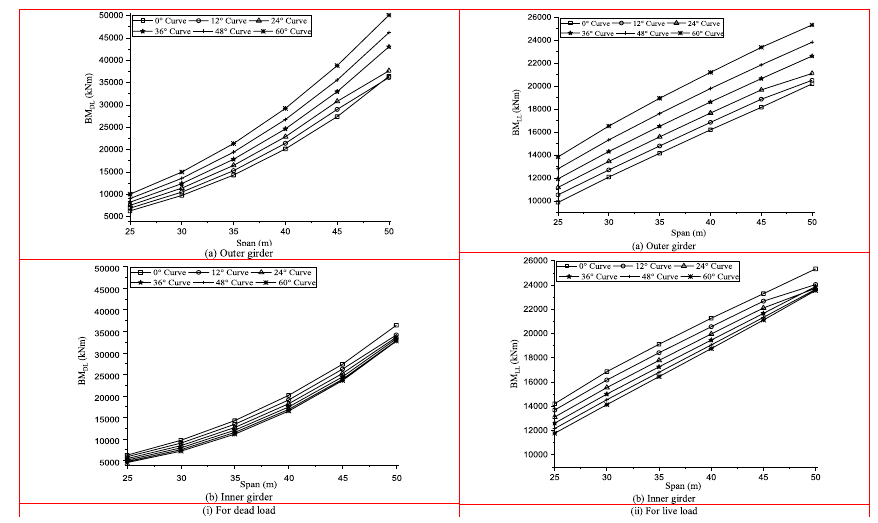
Fig. 13 Variation of bending moment with span for different curve angle. a Outer girder. b Inner girder. (i) For dead load. (ii) For live